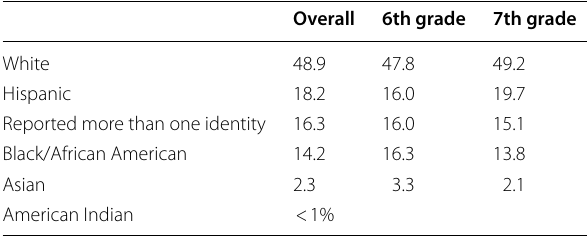
Total sample ( n 2016) consists of 996 6th graders and 1020 7th graders. Data = were collected at time point 1 (Fall 2012). These values do not include missing responses (24.1% of the